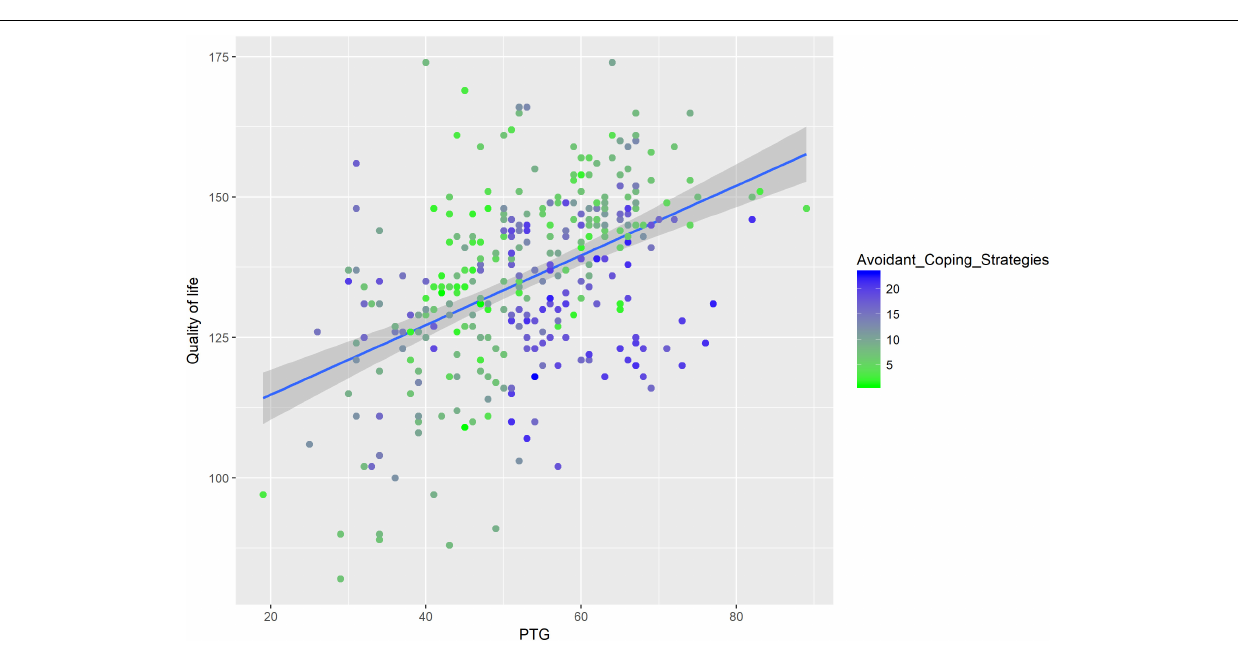
would negatively affect QoL. However, for the patients who (e.g., positive reappraisal), there may be deliberate